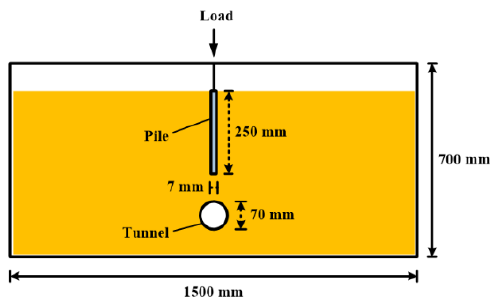
Figure 17. Pile and tunnel model used in numerical simulation.